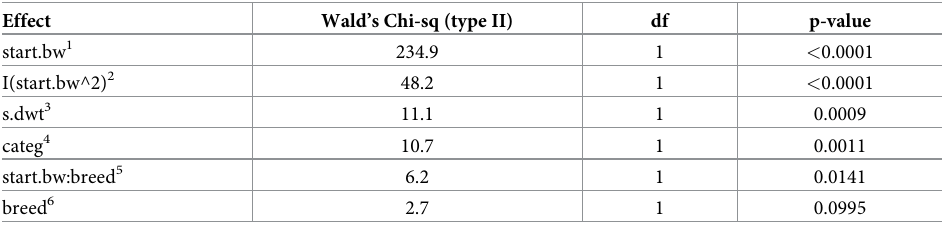
Table 3. Analysis of variance of the model for pregnancy rate with proximate